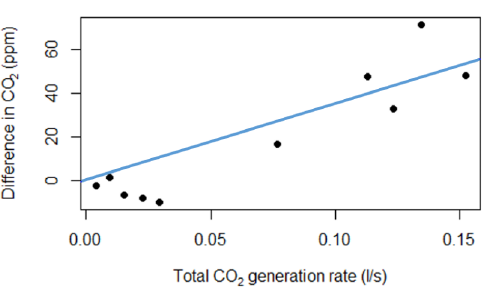
Fig 2. Difference between indoor and outdoor CO 2 readings (ppm = parts per million) against the total CO 2 generation rate at each time point (ls -1 ). Line represents the best fit by linear regression with y-intercept constrained to be